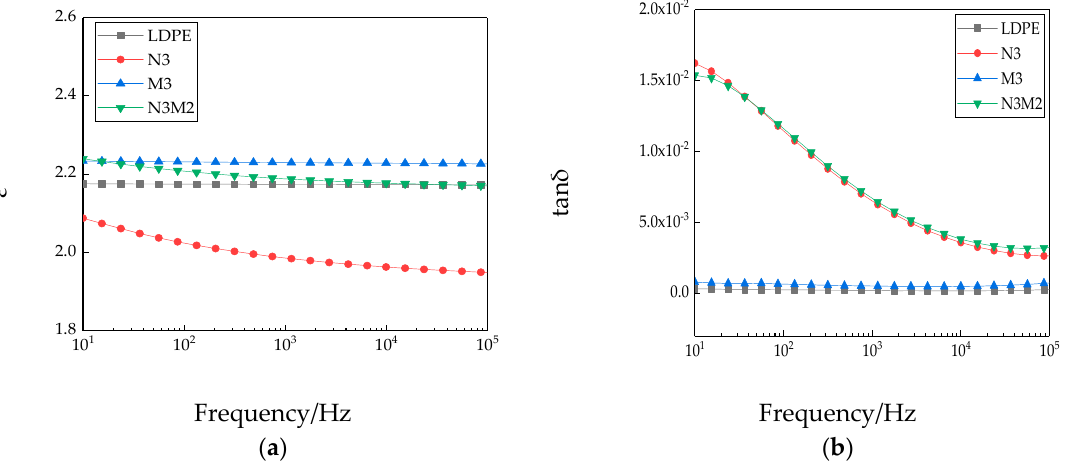
Figure 9. Variation in the dielectric constant and dissipation factors of different samples versus frequency: ( a ) variation in the dielectric constant of different samples versus frequency, ( b ) variation in the dissipation factors of different samples versus frequency.